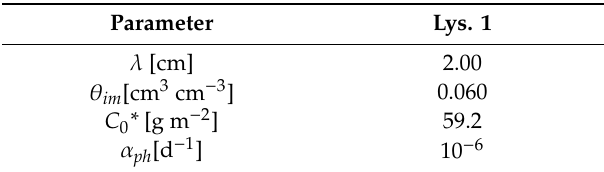
Table 8. Values of dispersivity, immobile water content and mass exchange coe ffi cient parameters manually set using HYDRUS-1D for all soil materials of Lys. 1. Initial amounts of bromide manually re-optimized are noted C 0 *